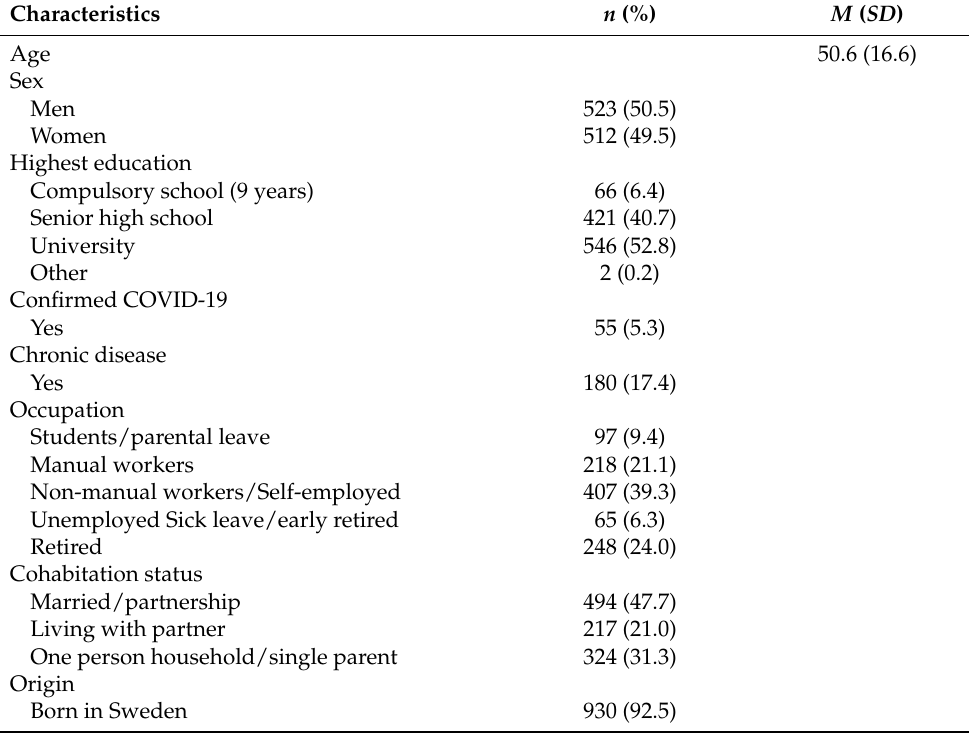
Table 1. Descriptive characteristics of the sample ( N =